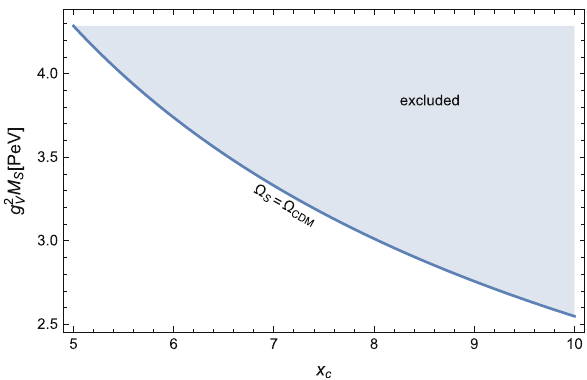
M S for 5 ≤ x c ≡ V